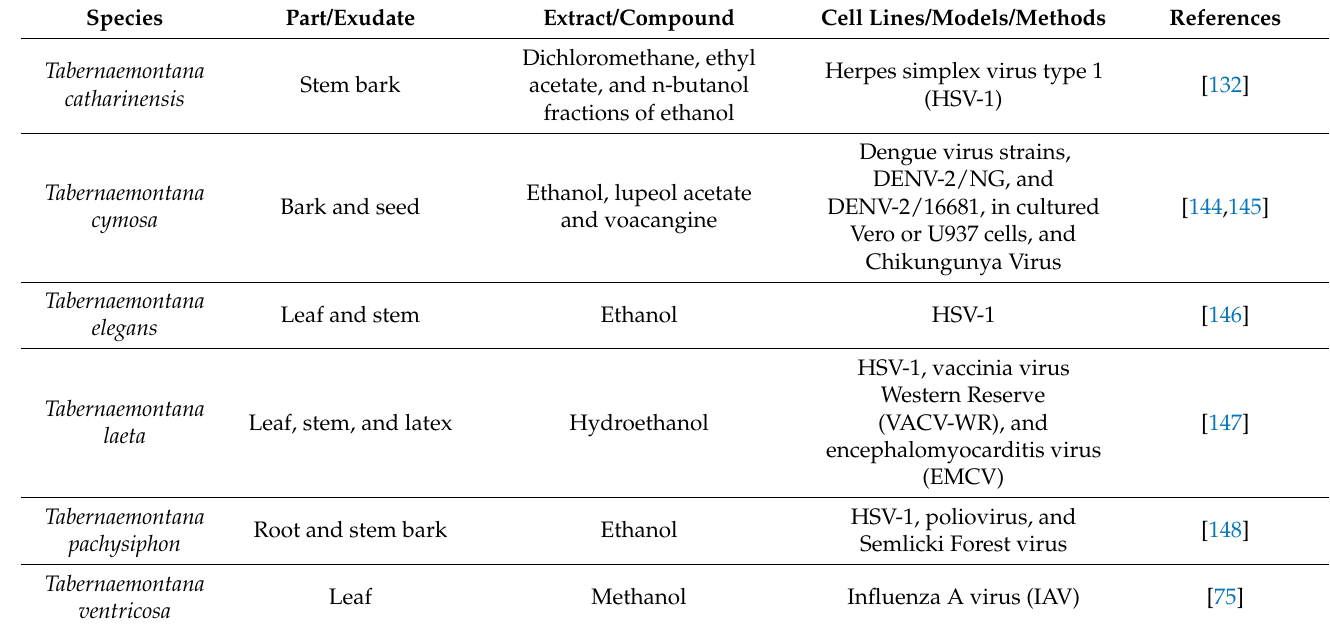
Table 5. Antiviral activities of extracts and compounds isolated from Tabernaemontana species.